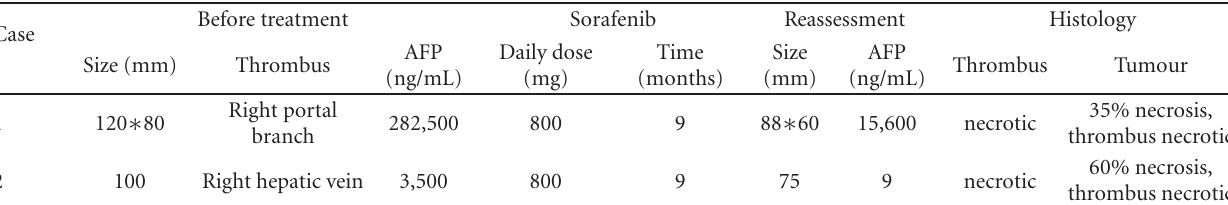
Table 1: Summarize of patients’